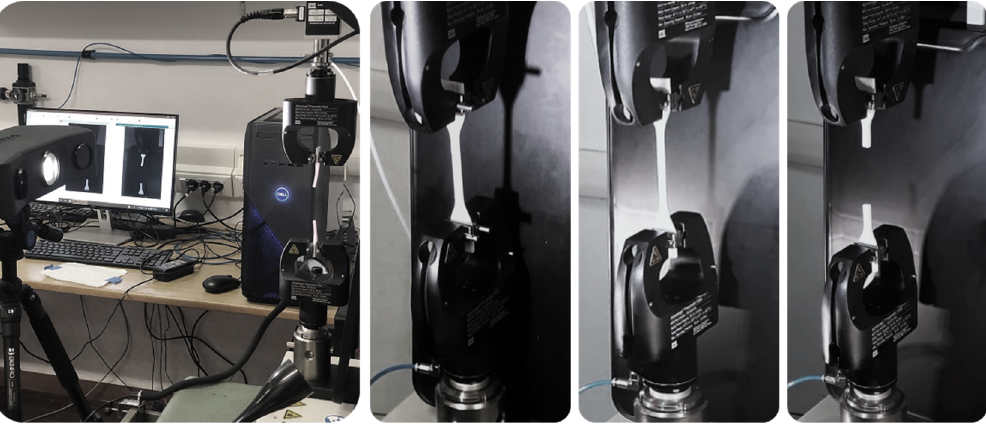
Figure 4. Experimental mechanical testing setup. The deformation of the dog-bone specimen in the initial elastic stage until failure is shown.